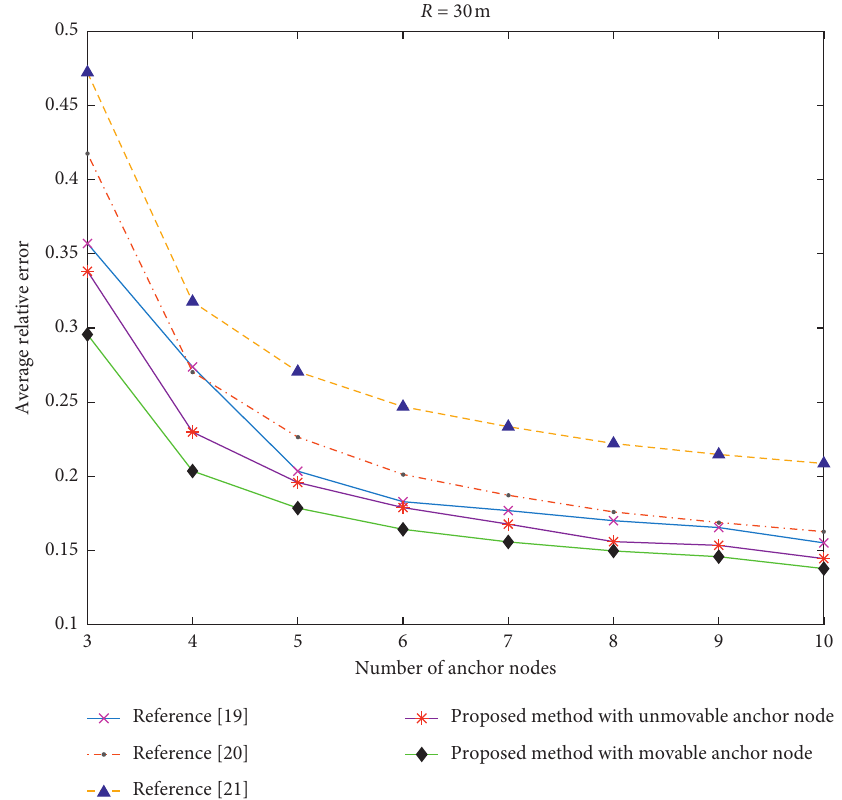
Figure 3: The average relative error with different number of anchor nodes and communication radius 30 meters.